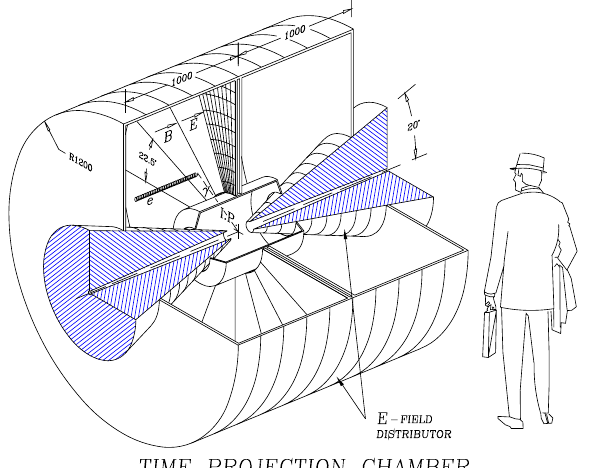
FIG. 74. (Color) Outer tracker TPC.